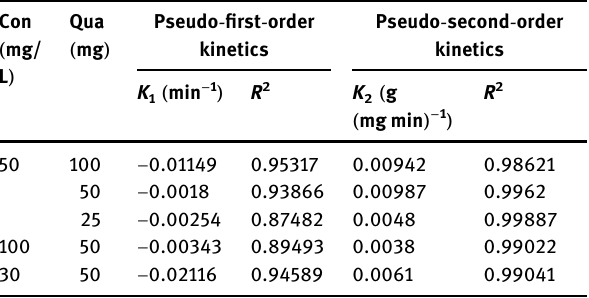
Table 2: Kinetic parameters for CR over Zn -